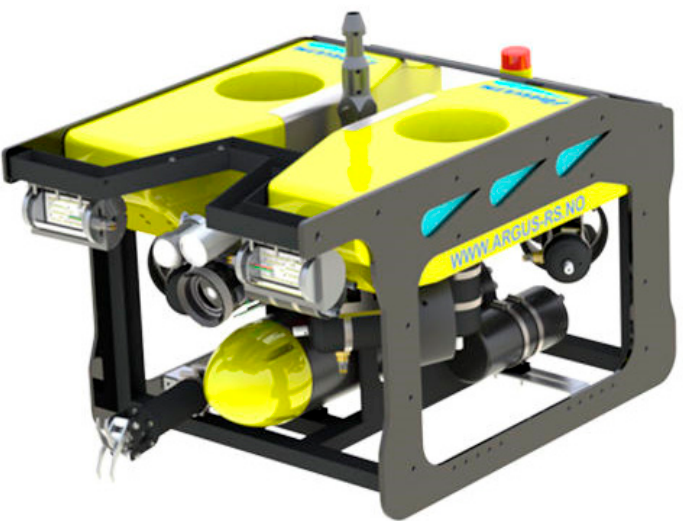
Figure 1. The Argus Mini remotely operated vehicle (ROV), courtesy of Argus Remote Systems